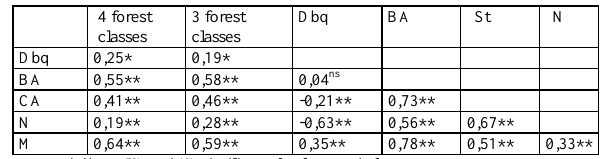
Table 1. Pearson correlation matrix for forest variables